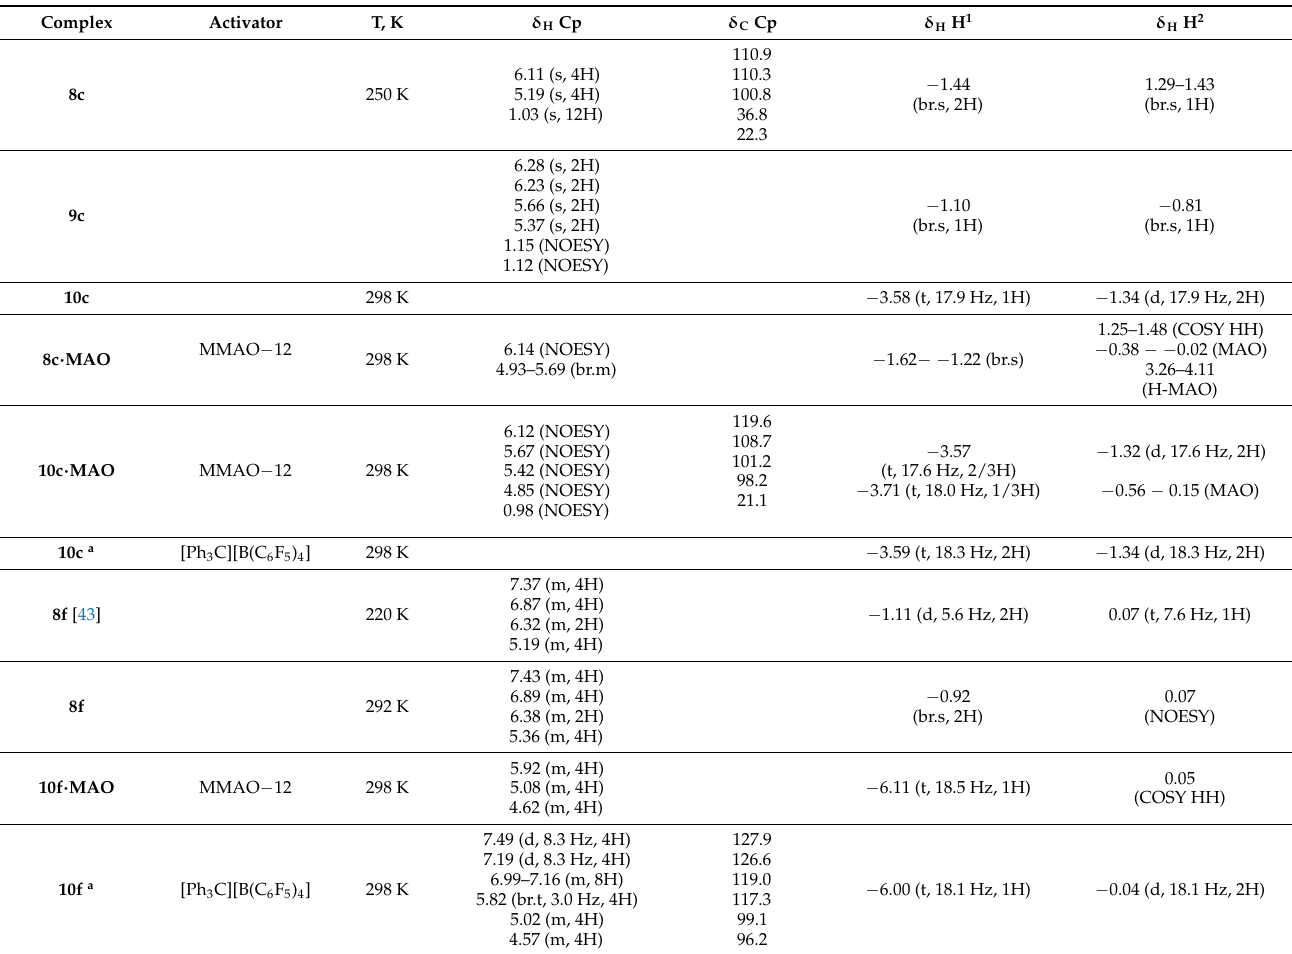
Table 2. 1 H and 13 C NMR ( δ , ppm, 400.13 MHz ( 1 H), 100.62 MHz ( 13 C)) of hydride